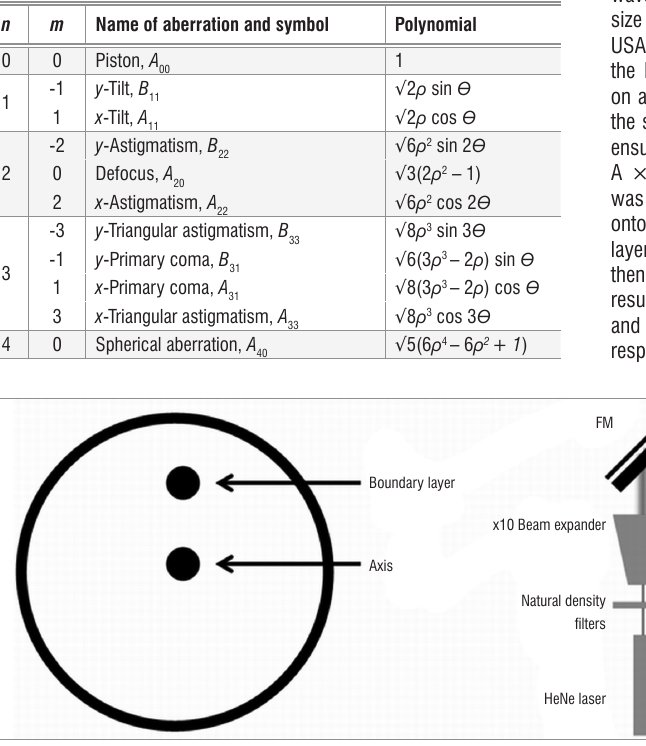
(a) A cross-section of the spinning pipe gas lens showing the propagation paths of laser beams along the axis and close to the wall above it. (b) Schematic of the experimental set-up for the measurement of the phase to determine turbulence parameters of the spinning pipe gas